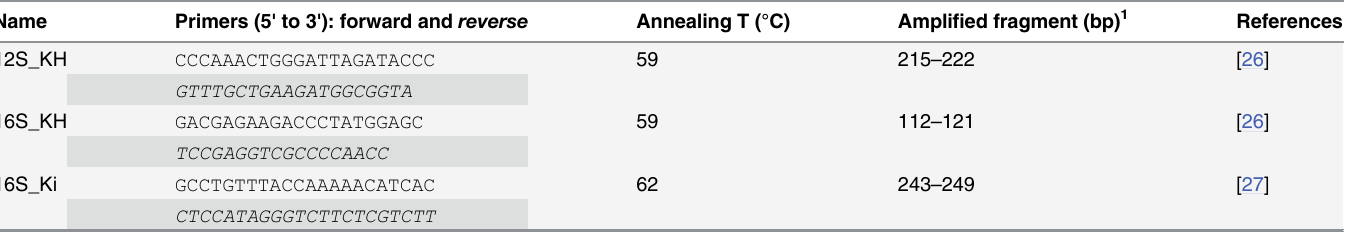
Table 2. Primer pairs used for DNA amplification [26,